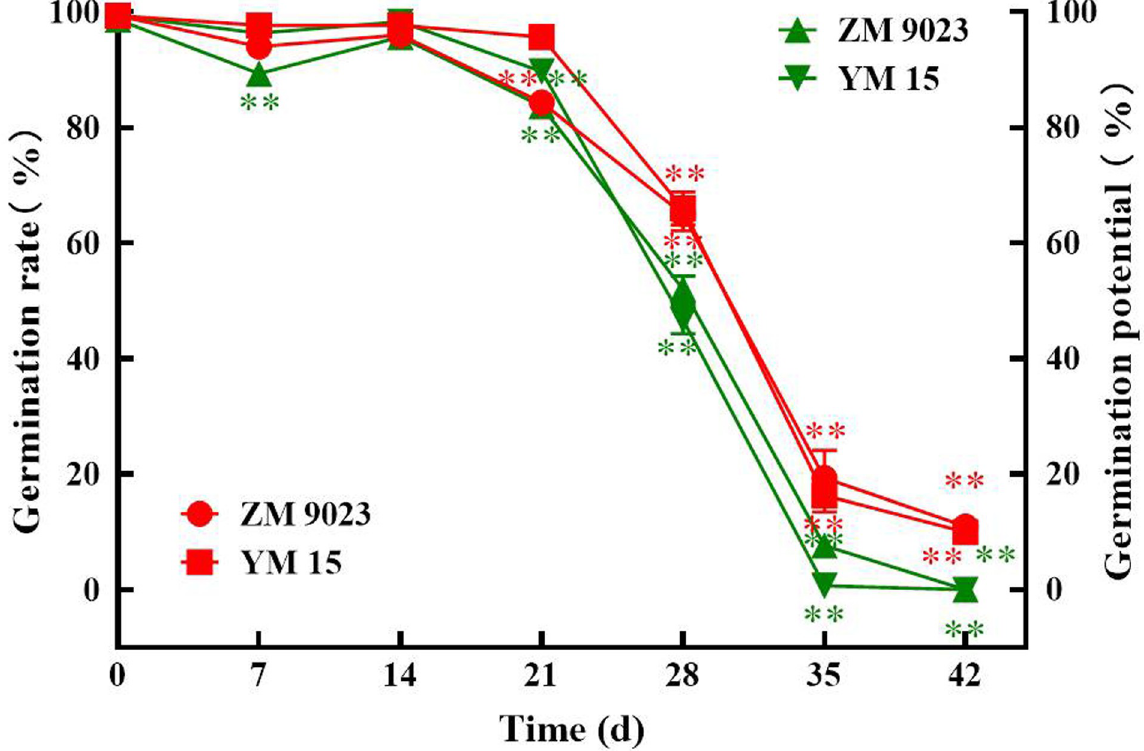
Fig 1. Effects of the artificial aging treatment on wheat seed vigor. Influence of artificial aging treatment on the wheat seed (A) germination potential and (B) germination rate. At least three independent experiments were performed; data are shown as mean ± SD. � p < 0.05; �� p < 0.005.